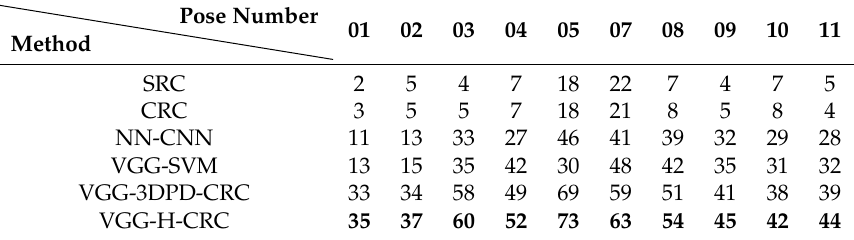
Table 8. Face recognition rates (%) with various head